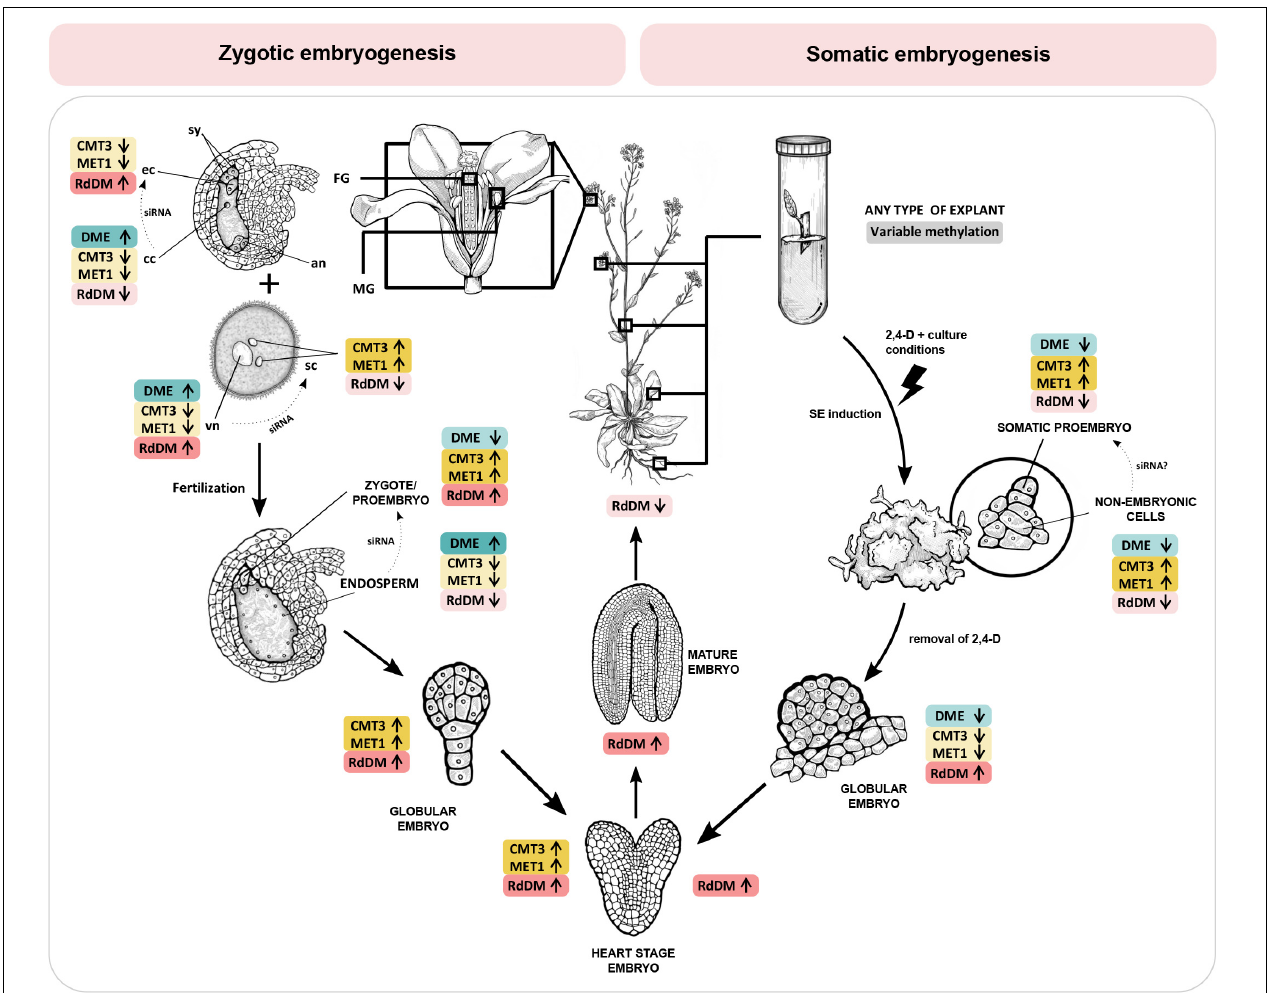
FIGURE 1 | DNA methylation mechanisms change activity during specific stages of zygotic and somatic embryogenesis in Arabidopsis thaliana . CMT3 and MET1 (yellow) maintain DNA methylation in CHG and CG context, respectively. The RdDM pathway (red) methylates DNA de novo in all contexts, and DME (blue) actively demethylates DNA regardless of context. Zygotic embryogenesis (left) . Before fertilization, RdDM is the dominant DNA methylation mechanism in the egg cell. Conversely, in the central cell, CMT3, MET1 and RdDM activity is low and DME activity is high, resulting in DNA hypomethylation. In the two spermal cells, CMT3 and MET1 are the dominant methyltransferases. Conversely, in the vegetative cell CMT3 and MET1 activity is low and DME activity is high, resulting in DNA hypomethylation. RdDM activity in the vegetative nucleus progressively increases. Embryogenesis begins when two spermal cells fertilize the egg and central cell of the female gametophyte, respectively. After fertilization, DNA methylation in the zygote and proembryo increases due to inherited activity of RdDM and increased expression of MET1 and CMT3. In the endosperm, all three methylation mechanisms reduce their activity, and DME remains active, resulting in DNA hypomethylation. RdDM activity progressively increases during embryo maturation, and drops after germination. Somatic embryogenesis (right) . Upon induction of somatic embryogenesis by 2,4-D and specific culture conditions, CMT3 and MET1 become the dominant methyltransferases in both the somatic embryo and the surrounding non-embryonic cell clusters. DME activity is low. RdDM activity is initially low but progressively increases during embryo maturation, following a course similar to zygotic embryogenesis. The DNA of the central cell, vegetative nucleus and the endosperm is hypomethylated, resulting in expression of transposons and eventually biogenesis of siRNA which are transferred into the egg cell, spermal cells and the embryo, respectively (dotted arrows), to ensure genome stability. As of yet, there is no evidence of siRNA-mediated communication between somatic proembryo and non-embryonic cells in culture. Information presented in the figure is based on findings published in Jullien et al. (2012); Grzybkowska et al. (2018), and Gehring (2019). 2,4-D, 2,4-dichlorophenoxyacetic acid; an, antipodal cells; cc, central cell; CMT3, CHROMOMETHYLASE 3; DME, DEMETER DNA GLYCOSYLASE; ec, egg cell; FG, female gametophyte; MET1, DNA